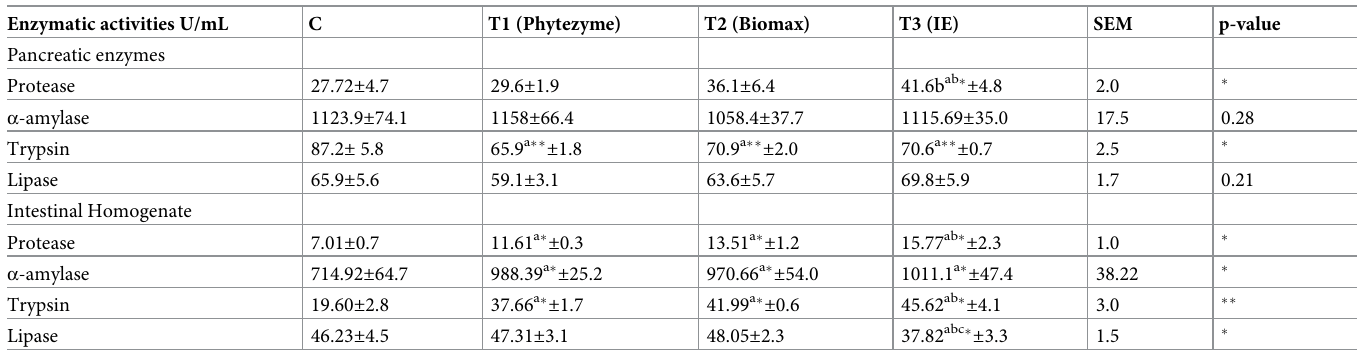
Table 2. Enzyme activities in the pancreases and intestine in the birds.